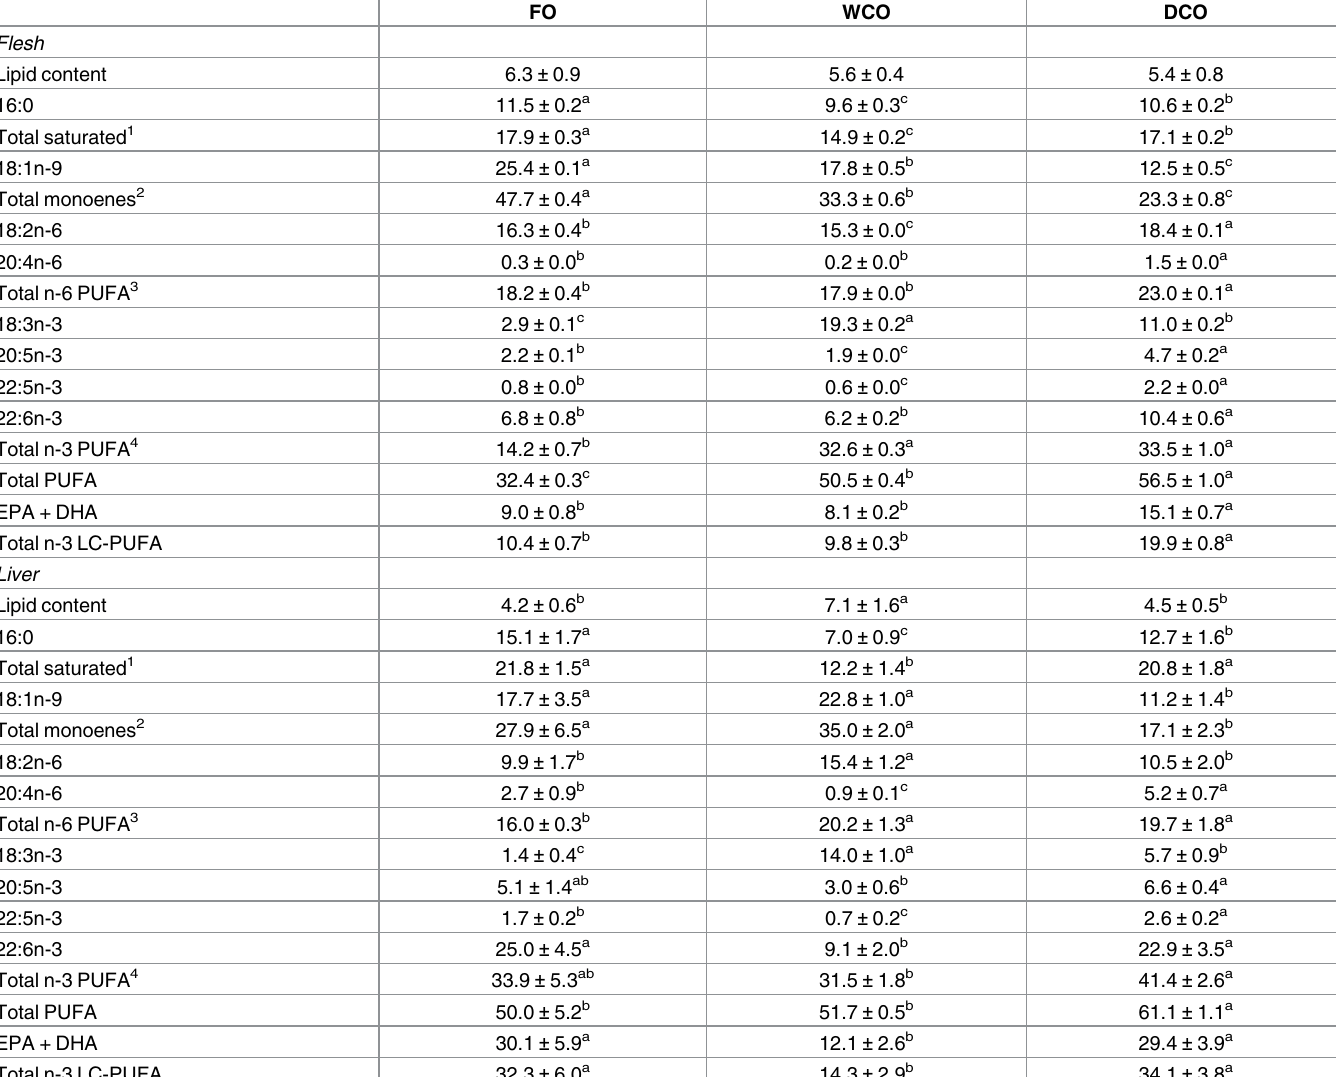
Table 3. Lipid contents (percentage of wet weight) and fatty acid compositions (percentage of total fatty acids) of total lipid of flesh and liver after feeding the experimental diets for 12 weeks. FO WCO